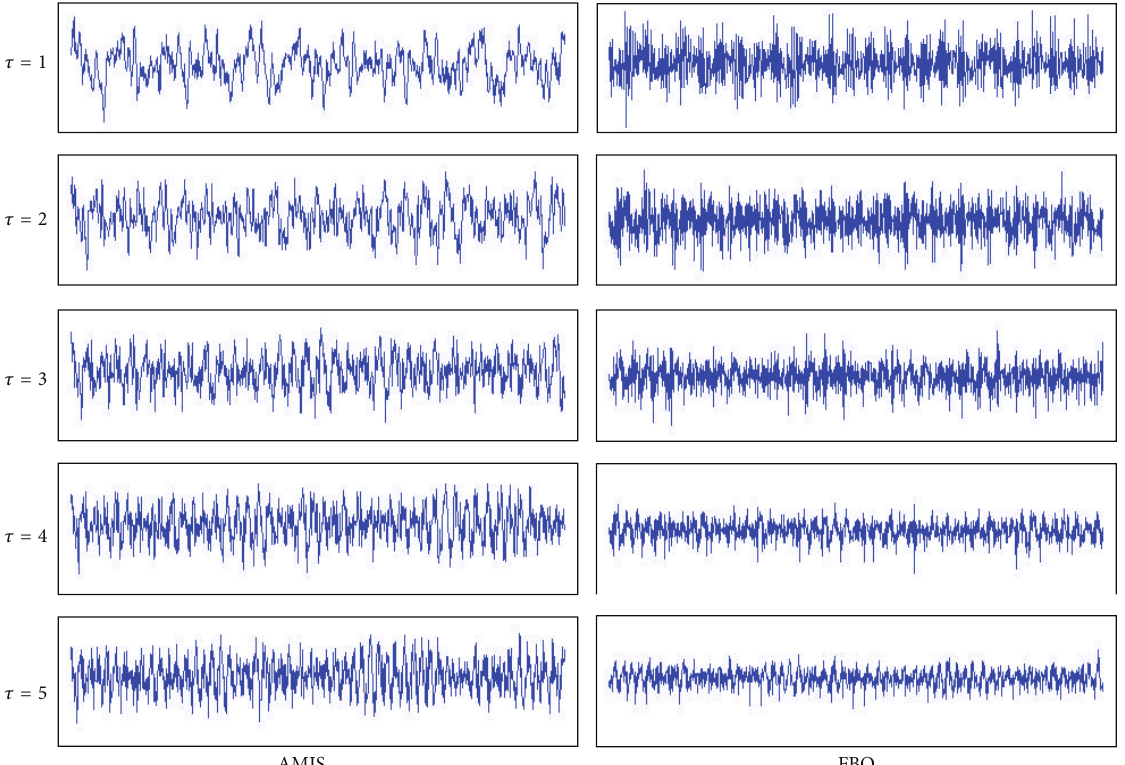
Figure 9: Time waveforms of coarse-grained time series.